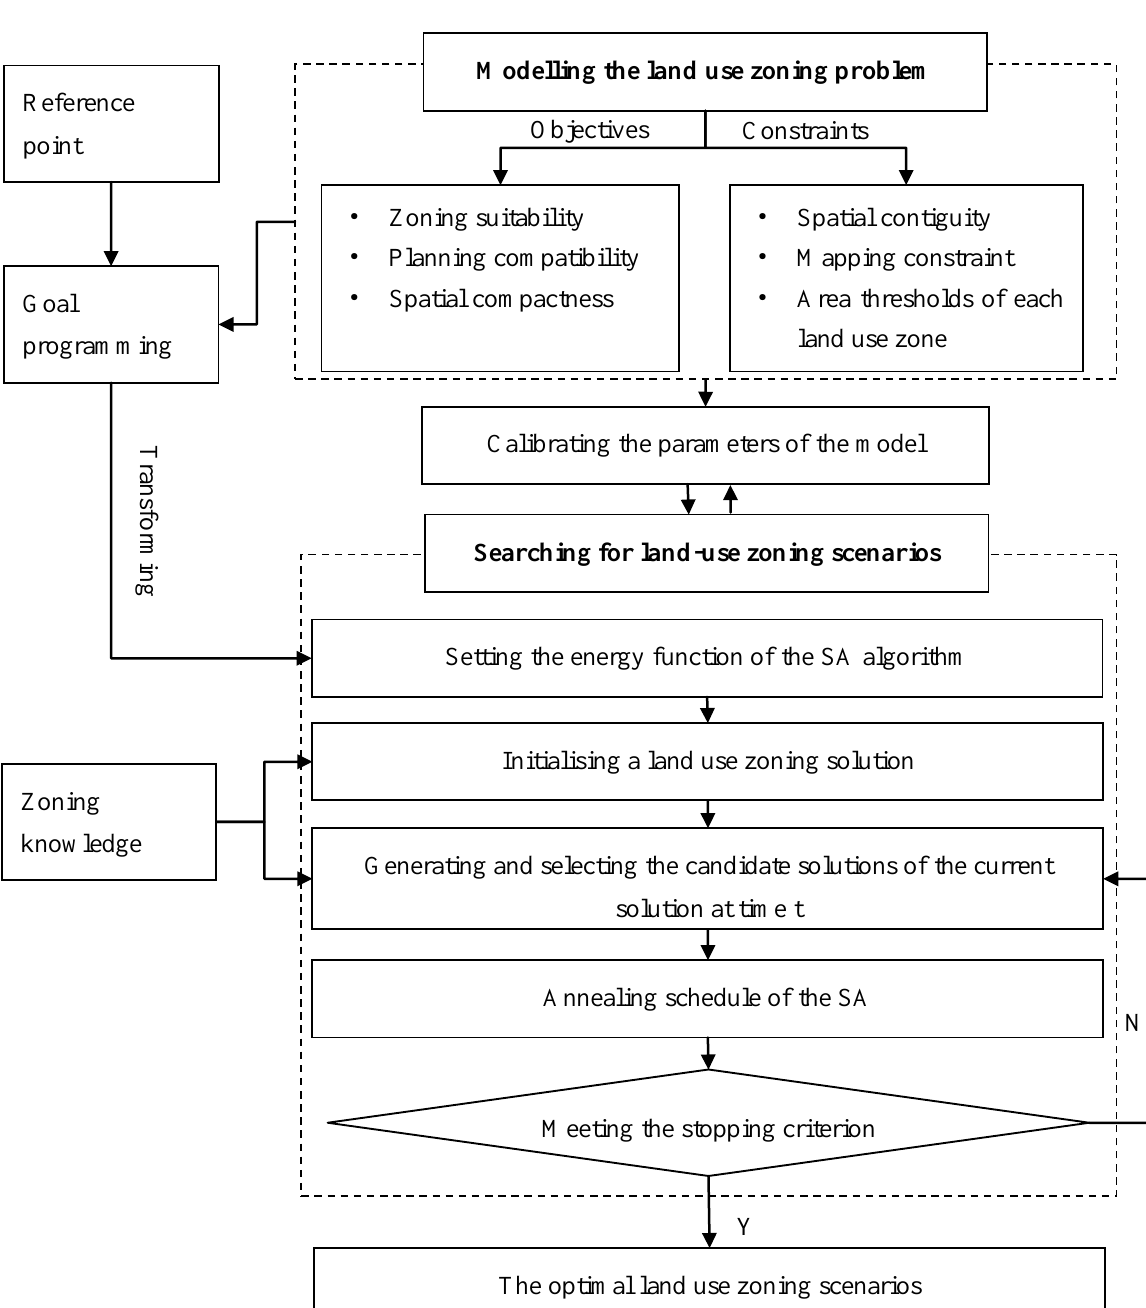
Figure 3. A flow chart of zoning